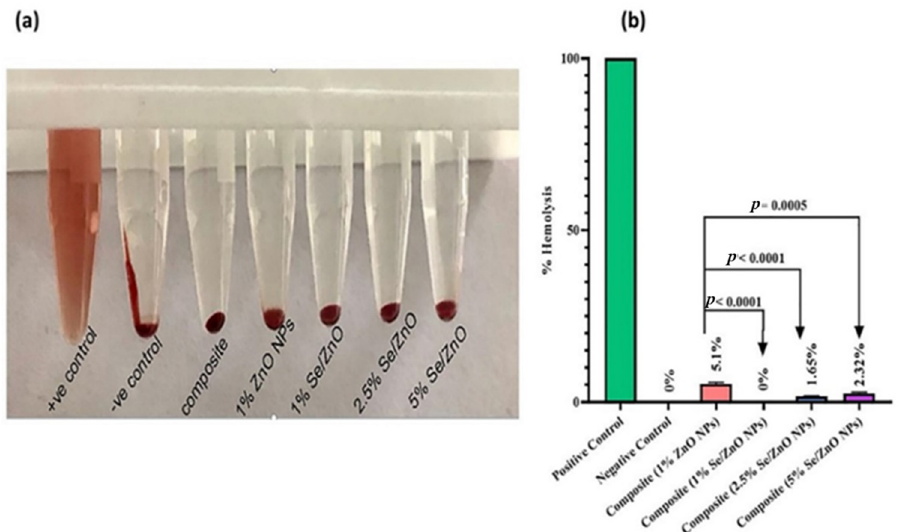
Figure 7. Hemolytic activity of resin composite ZnO NPs and Se/ZnO NPs. ( a ) Supernatant does not show any hemolysis of RBCs except positive control that shows 100% hemolysis of RBCs and ( b ) statistically significant reduction in hemolysis ( p <